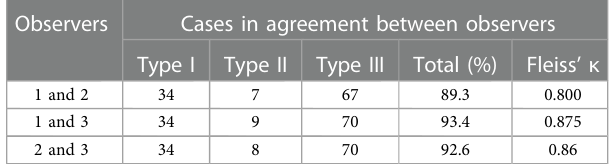
TABLE 5 Inter-observer reliability of the XX classi fi cation.